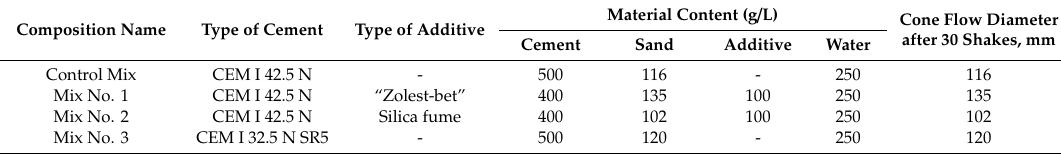
Table 3. Concrete mixtures for sulfate durability test.